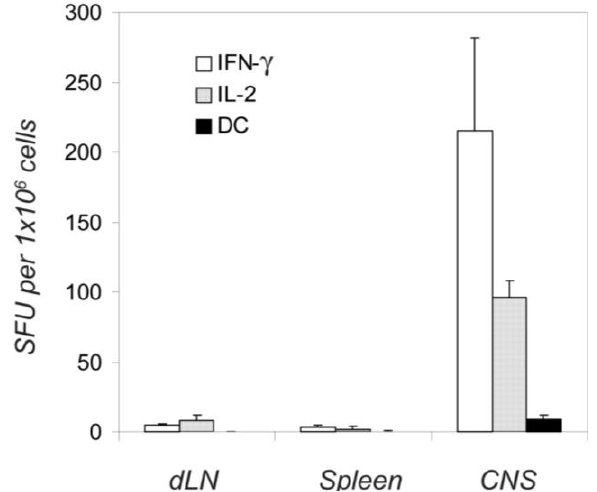
Figure 3. Endogenously activated autoreactive T cells produce either IFN- (cid:534)(cid:3)(cid:82)(cid:85)(cid:3)(cid:44)(cid:47) -2, but not both simultaneously (double color, DC). Twelve days after the immunization with the PLP peptide, 1 × 10 6 unseparated dLN cells, spleen cells, and spinal cord mononuclear cells were plated per well and tested in an IFN- (cid:534)(cid:3)(cid:18)(cid:44)(cid:47) -2 double color ELISPOT assay of 48 h duration. Single and double color spots were counted by image analysis. Means and SD of spot forming cells for four independent experiments are shown, with triplicate wells in each